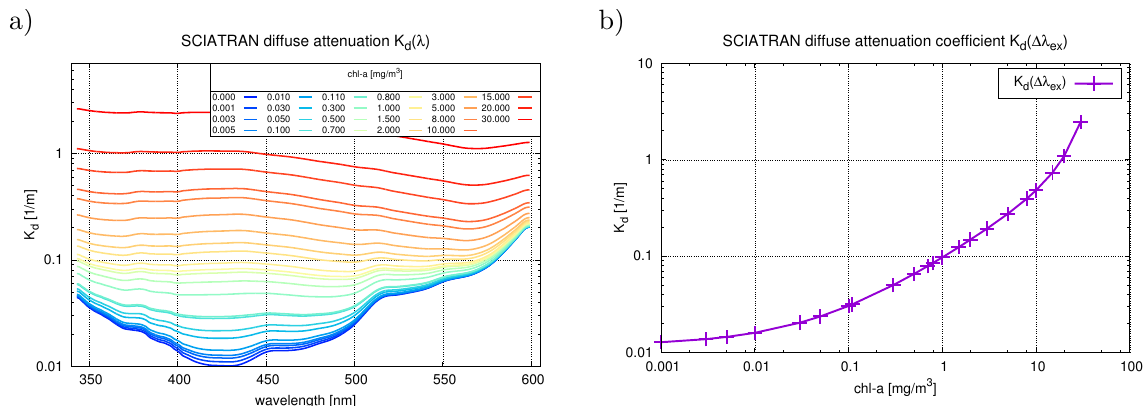
Figure 4. (a) Spectral resolved K d (λ) for different chl a . (b) Averaged diffuse attenuation coefficient for the VRS excitation wavelength region K d ((cid:49)λ ex ) calculated according to Eq. (23).